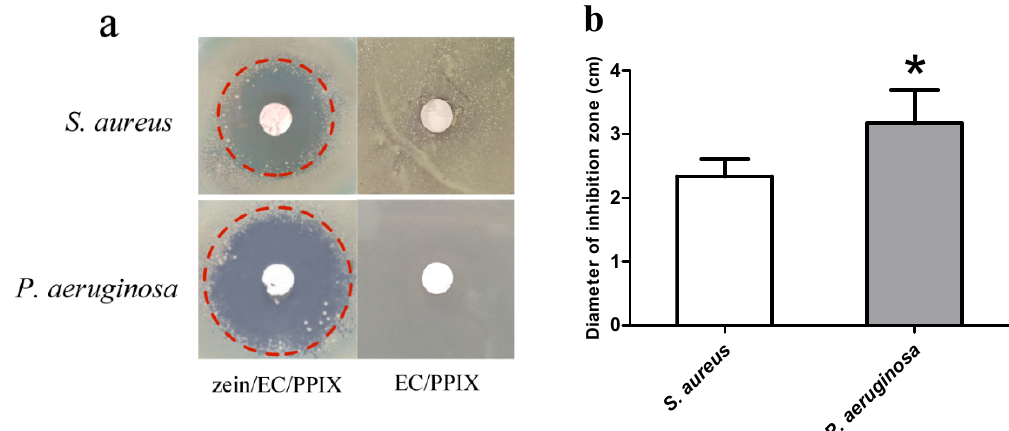
Figure 4. ( a ) The images of inhibition zones obtained by incubating S. aureus or P. aeruginosa with the zein/EC/PPIX nanofibrous membrane (ABL) and the EC/PPIX nanofibrous membrane. ( b ) Diameter statistics of the inhibition zone. * represents a statistically significant difference from the S. aureus group ( p < 0.05).